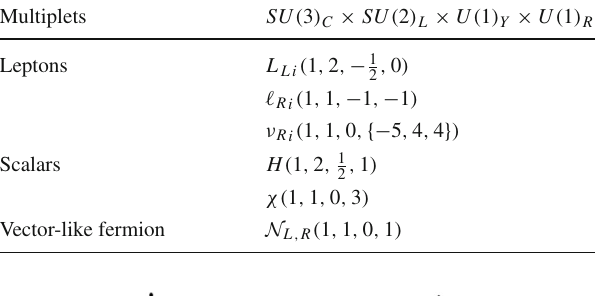
Table 4 Quantum numbers of the fermions and the scalars in radiative Dirac model